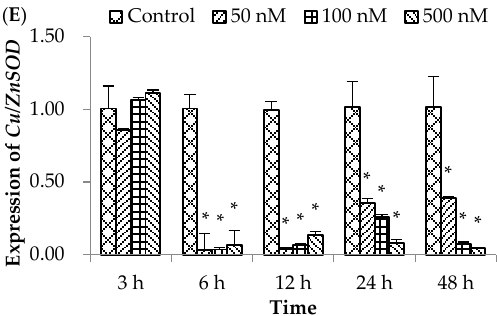
Figure 2. Effects of okadaic acid (OA) on non-specific immune responses in the bay scallop Argopecten irradians at different time intervals following exposure to three concentrations (50, 100, and 500 nM) of OA. ( A ) CTL-6 gene; ( B ) FREP gene; ( C ) HSP90 gene; ( D ) MT gene; and ( E ) Cu/ZnSOD gene. Data represent mean ± SD values ( n = 9) at the same time intervals with different letters denoting significant differences ( p < 0.05).